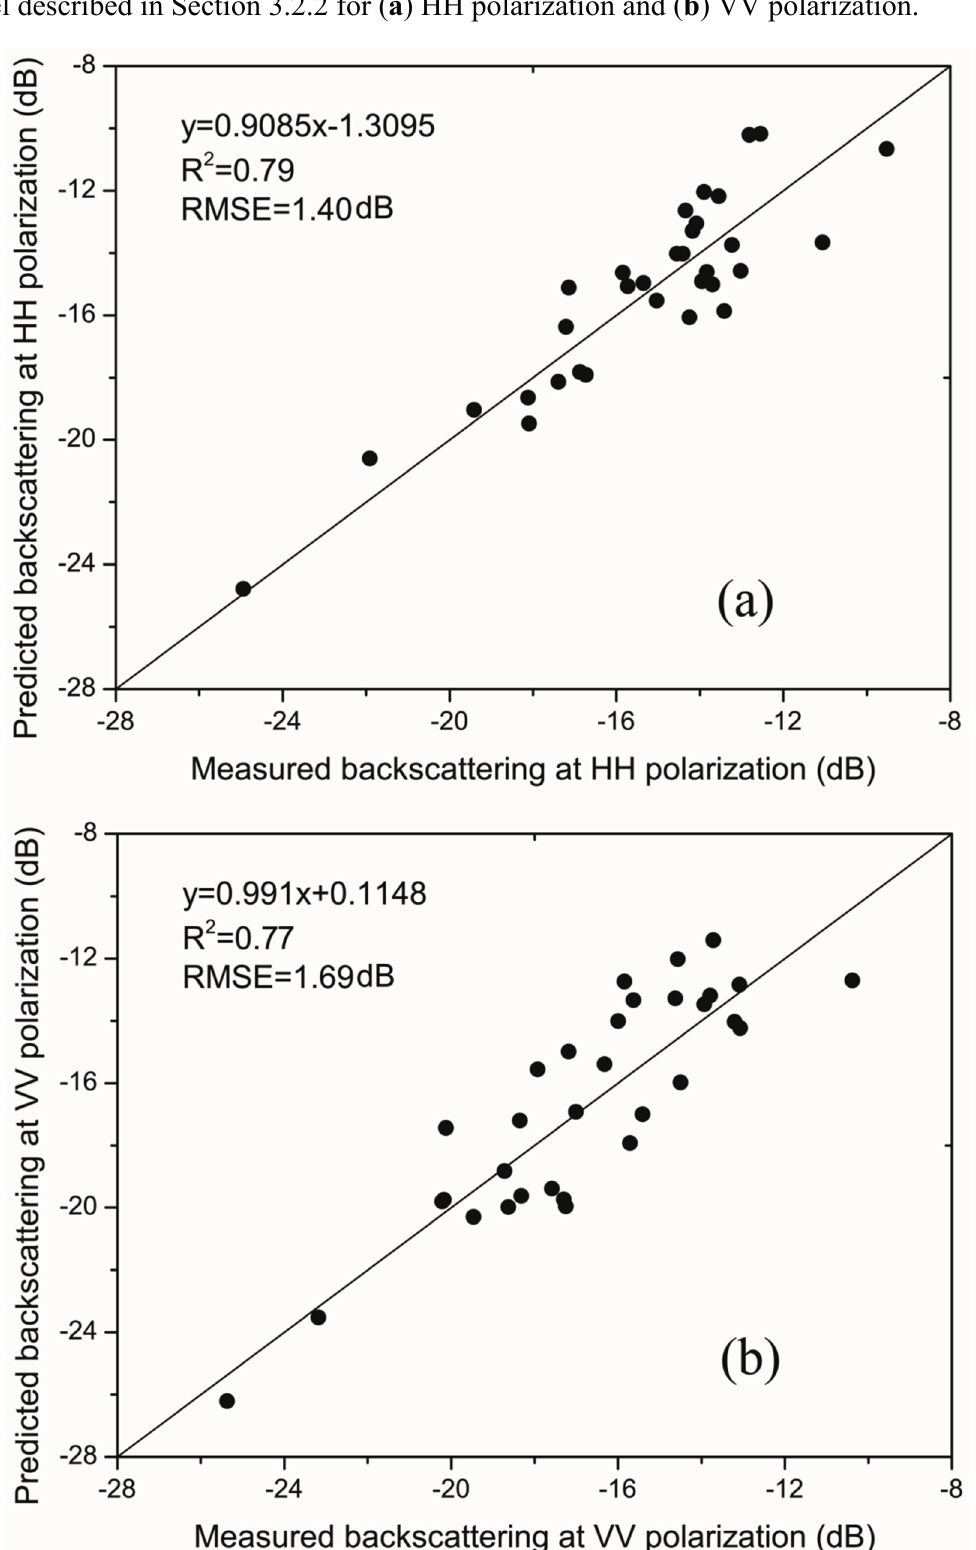
Figure 3. Scatterplot illustrating the relationship between the measured backscattering from the images and predicted backscattering values from the modified vegetation backscattering model described in Section 3.2.2 for ( a ) HH polarization and ( b ) VV